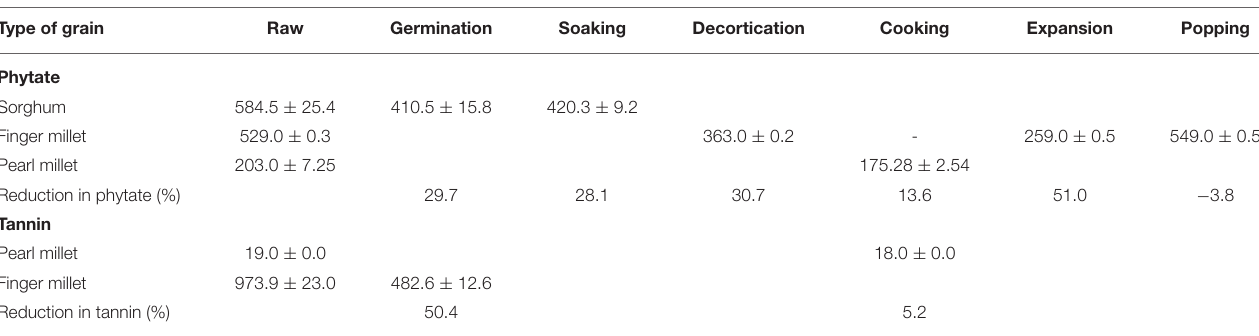
TABLE 4 | The effects of processing on phytate and tannin content in millets